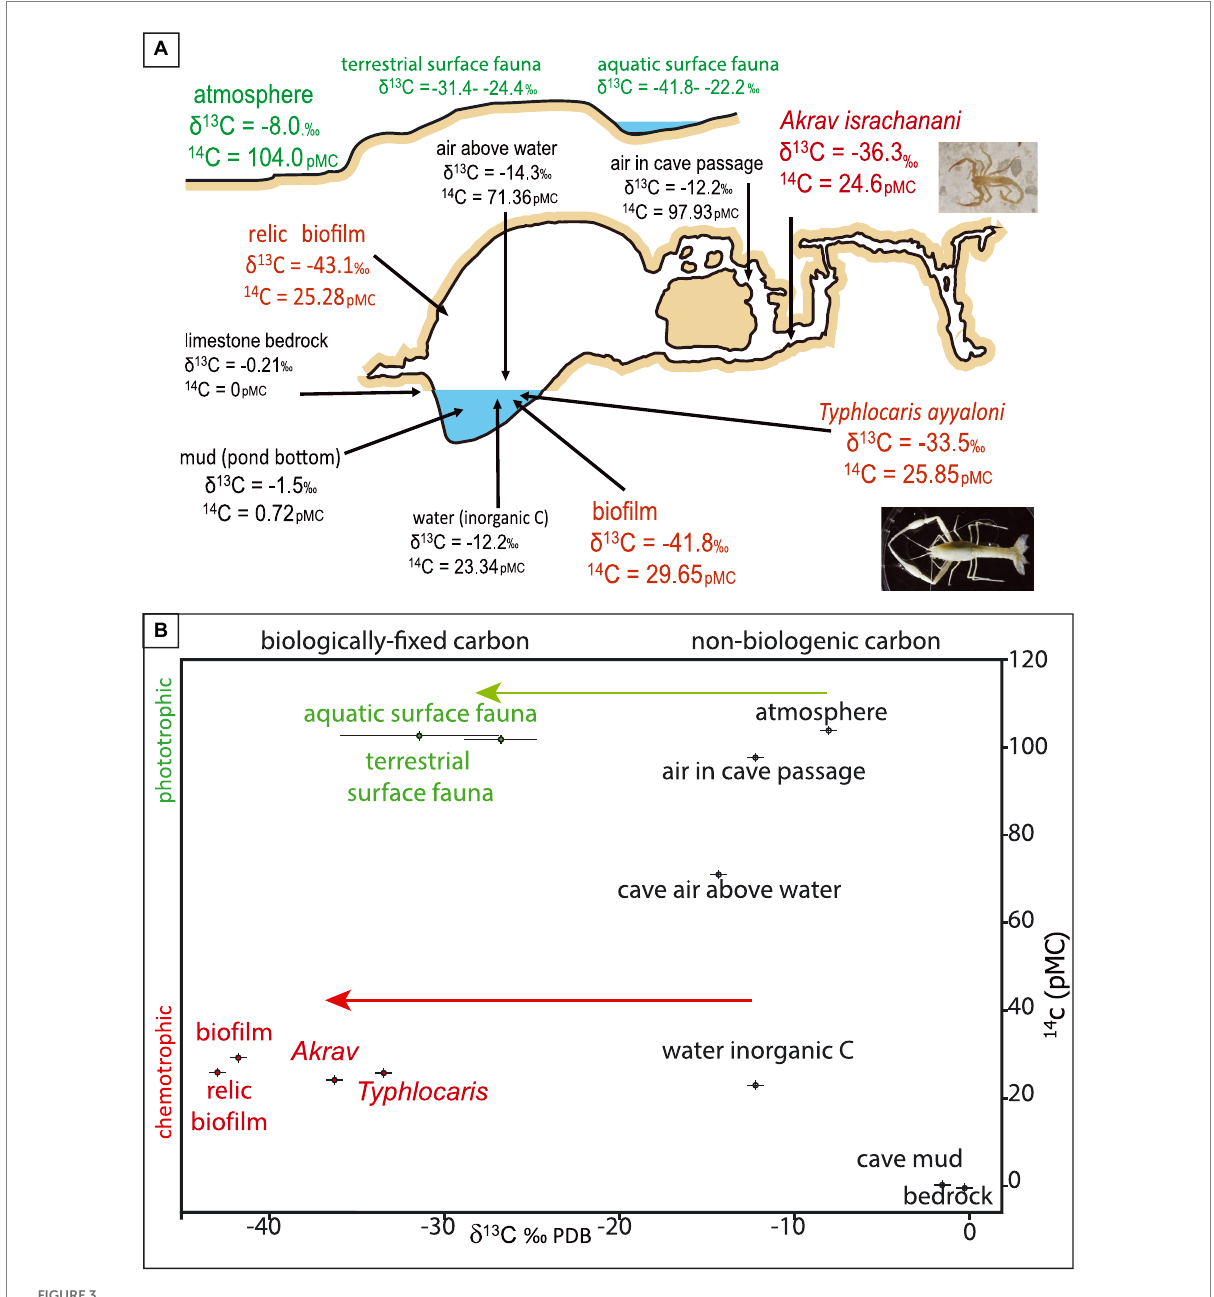
FIGURE 3 Carbon isotopes of the Ayyalon cave and surrounding surface, showing the isotopic difference between the surface phototrophic (green) and cave chemotrophic (red) systems. 14 C of surface fauna was assumed to replicate the atmospheric value. (A) cartoon indicating the measured values of the samples and their general location. (B) the relation between 14 C and δ 13 C of the system’s components. Green arrow represents ~ − 20‰ fractionation associated with photosynthesis by C 3 plants, subsequently consumed by surface fauna (shown). Red arrow represents fractionation associated with chemoautotrophic sulfur-oxidizing bacteria (Ruby et al., 1987). Individual samples with 1 σ laboratory error are shown, except for surface fauna, whose gross diversity is represented by the average values of 15 aquatic species and 11 terrestrial species, with 1 σ standard deviation of each group (further details in Tables 3,